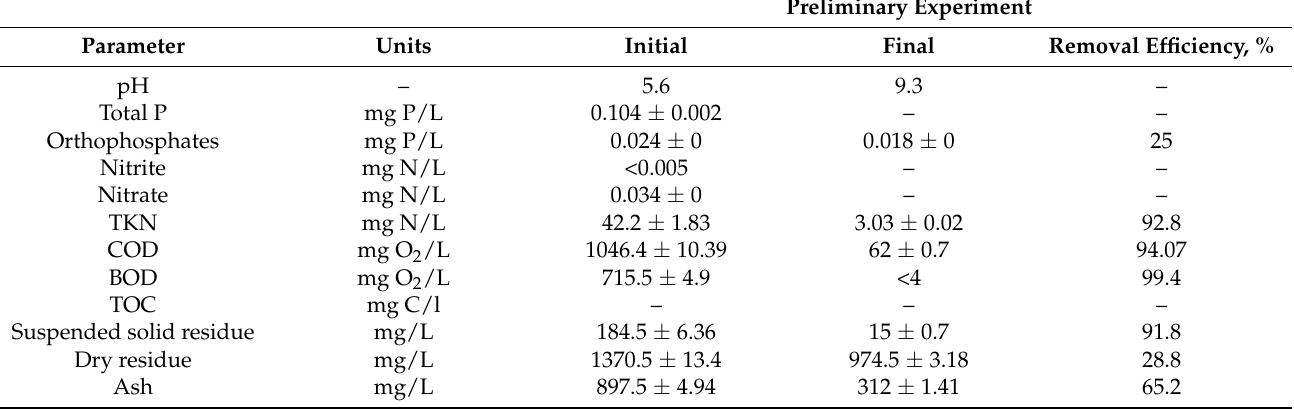
Table 1. Physicochemical characterization and removal efficiency of certain components in the initial sugar plant wastewater and the wastewater after microalgae treatment during the preliminary